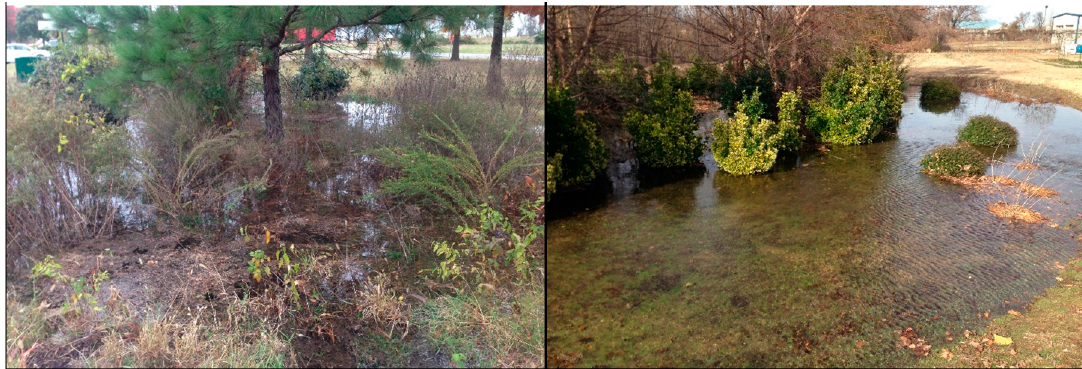
Figure 6. Mature BRC in 2014 ponded during hydraulic testing; ( left ) GLA, ( right ) GHS.